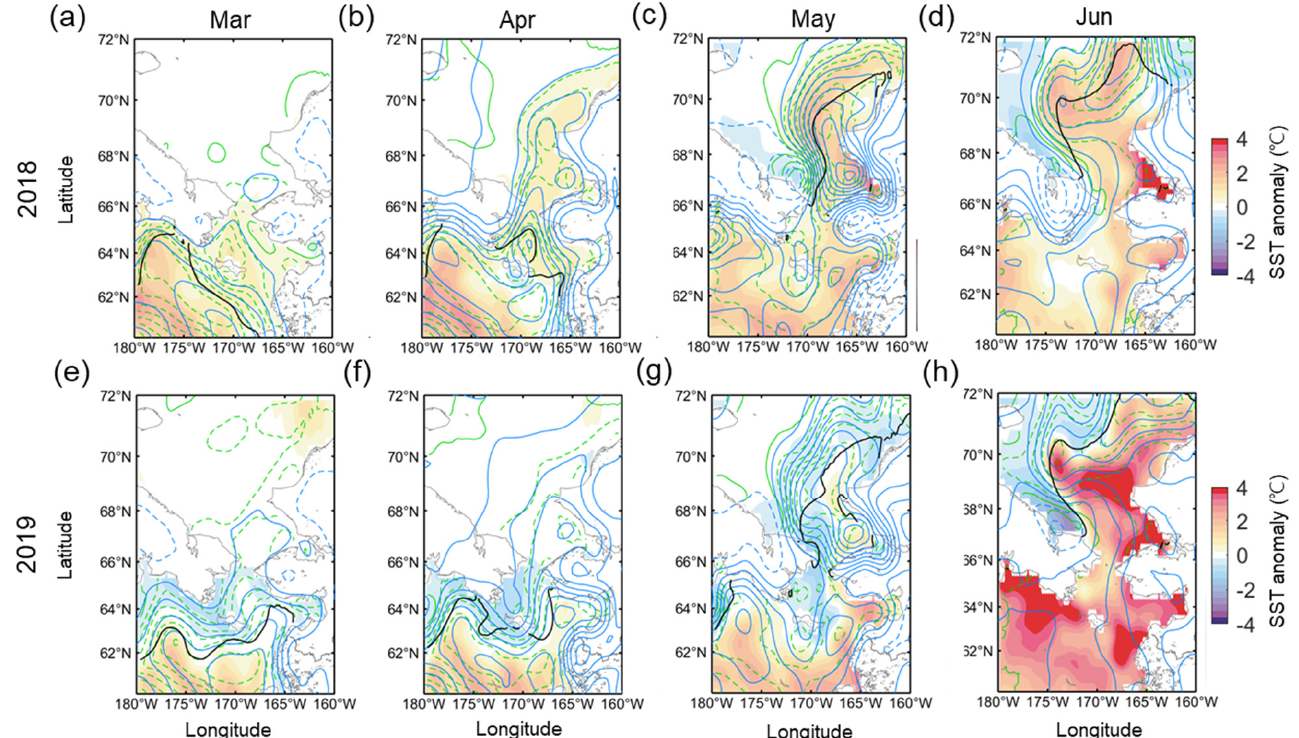
Figure 7. The distribution of SST anomaly (color shading) during March to June in ( a – d ) 2018 and ( e – h ) 2019, including the net shortwave heat flux anomaly (blue contour with 10 W m − 2 interval) and SIC anomaly (green contours with 10% interval). The solid (dashed) contours denote positive (negative) values. The vertical heat fluxes are positive downwards. The thick black line denotes the marginal ice edge.